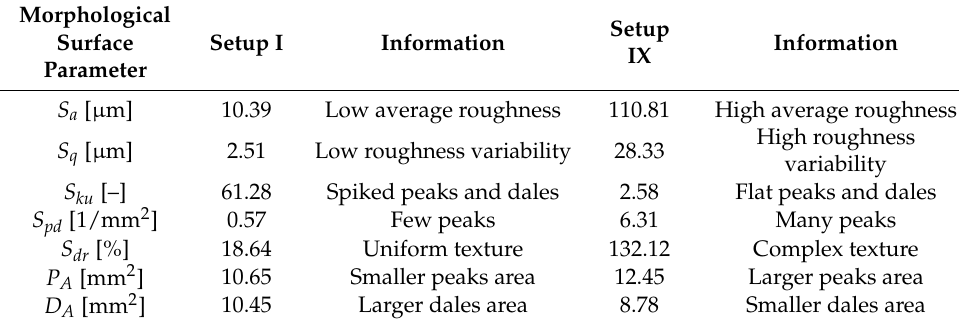
Table 6. Morphological surface parameters for setup I and setup The absence of adhesion for setup I was ascribable to the very good surface fi nishing